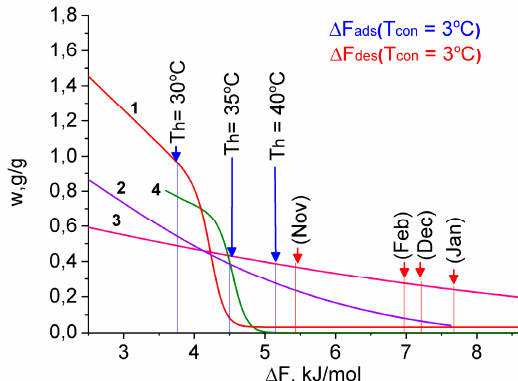
Figure 8. The boundary conditions of the HeCol cycle for Yakutsk and the universal adsorption curves for: 1—LiCl/MWCNT, 2—MaxSorbIII, 3—LiBr/SiO 2 , 4—LiCl/SiO 2 . The refrigerant is methanol.